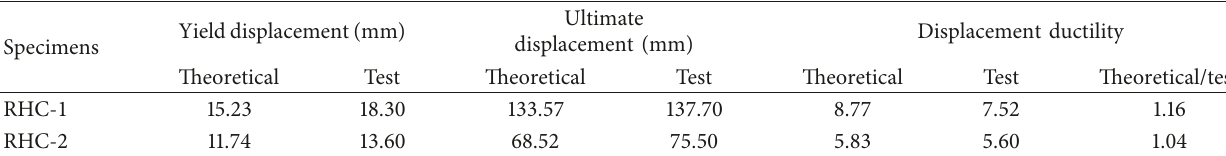
Table 5: Comparison of theoretical and test values of displacement ductility.